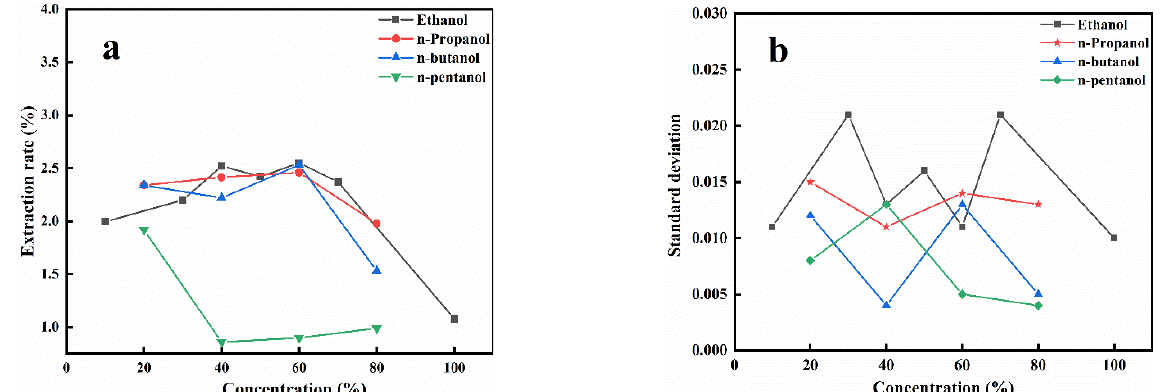
Figure 1. ( a ) Effects of alcohols with different carbon chain lengths on the extraction rate of CGA. ( b ) Standard deviation of the effect of carbon chain length on extraction rate.